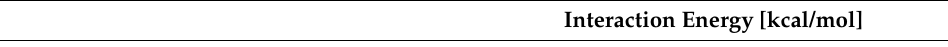
Interaction Energy [kcal/mol] In Vacuo